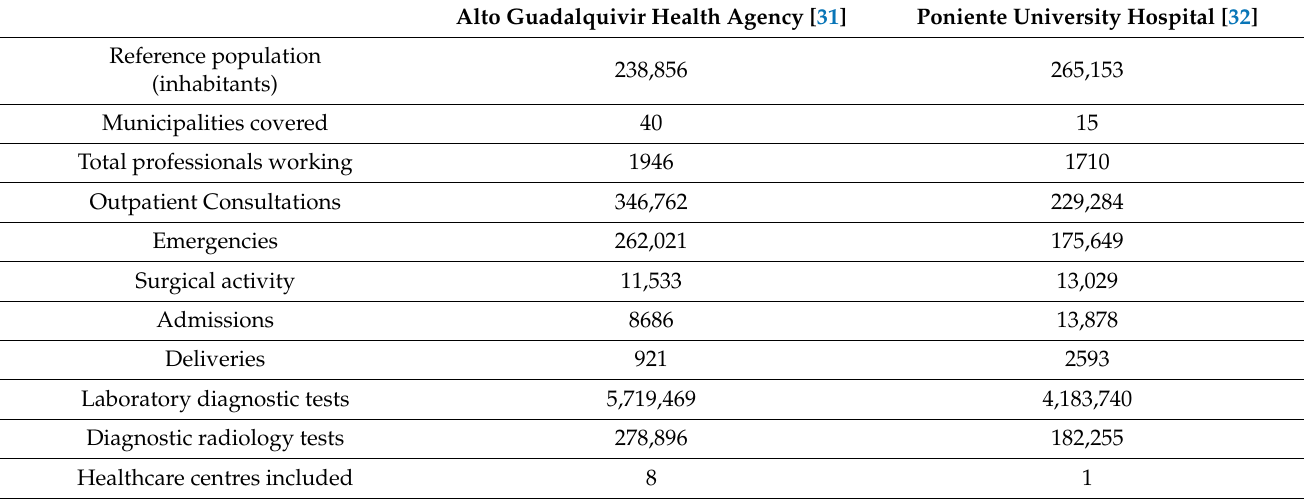
Table 1. Main characteristics of the regional hospitals included in the study (year